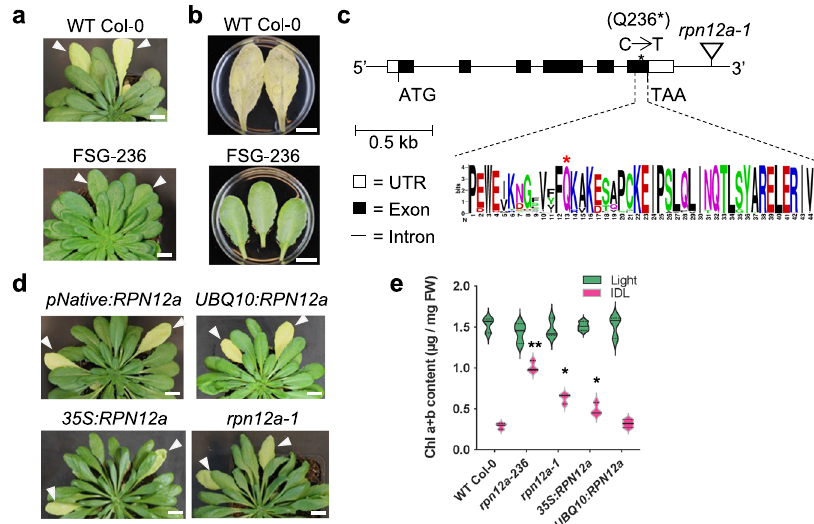
Fig. 1 Molecular and phenotypic characterization of the EMS mutant Arabidopsis mutants subjected to dark-induced senescence. a Senescence and stay-green phenotype of WT Col-0 and EMS mutant leaves individually darkened (IDL) for 7 days (white arrows), respectively, and b of detached leaves from 6-week-old plants, grown in SD, placed in darkness for 7 days in 3 mM MES (pH 5.7). c Localization of the EMS mutation in the RPN12a gene causing the stay-green phenotype due to a premature stop codon (Q236*) in the C-terminal end of the RPN12a protein. White boxes: UTR, dark boxes: exons, and lines: introns. Weblogo was used to visualize the sequence conservation in the 187 closest proteins aligning with the last 44 amino acids in the C-terminal region of RPN12a. The height of each letter (score on y -axis) indicates the relative frequency of an amino acid at a given position, whilst the overall height of the stack indicates sequence conservation at that position. Red asterisk (*): glutamine in position 236 which is turned into a stop codon. d Phenotype of individually darkened leaves (7 days) in two complemented lines (driven by a UBQ10 or 35S promotor), and a rpn12a-1 T-DNA mutant. e Chlorophyll content of the rpn12a mutants and complemented lines (from 6-week-old plants, grown in SD). The violin plots show a medium smoothing of the distribution of the data with the median (plain line) and two quartiles (dotted line); a Student ’ s t -test (two sided; n = 3 biologically independent replicates) showed statistically signi fi cant differences from WT Col-0 for similar treatment at * p < 0.05, ** p < 0.001. Scale bars = 1